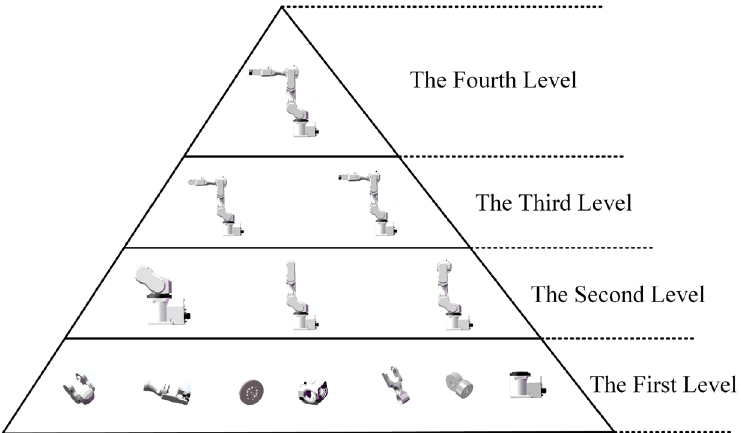
Figure 18. Logical relation construction of robot model.